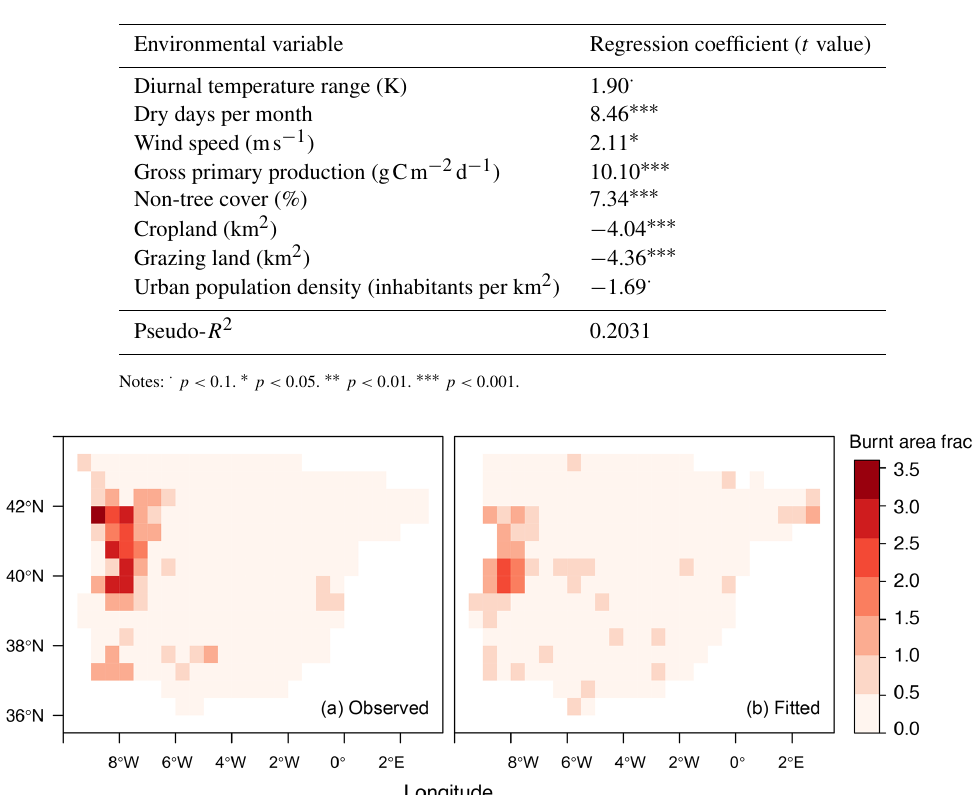
Table 1. Generalised linear model of the modern burnt area fraction.